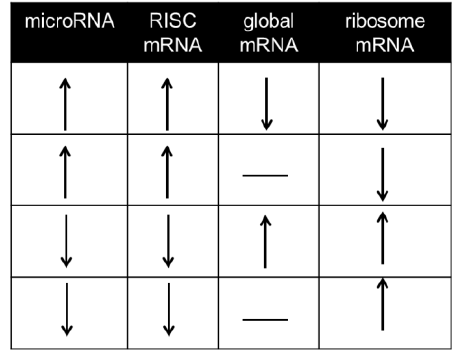
Figure 3. Regulatory parameters used to define microRNA-dependent mRNAs. Since suppression of mRNA translation without detectable decreases in global mRNA content has been widely reported in mammalian cells [45,60,61], it is worth considering as microRNA-dependent mRNAs those mRNAs whose abundance changes in the RISC in response to a given stimulus without exhibiting changes of global mRNA abundance (rows 2 and 4). mRNAs that do not exhibit alterations consistent with any one of these four rows are not considered to be microRNA-dependent under the paradigm outlined in this